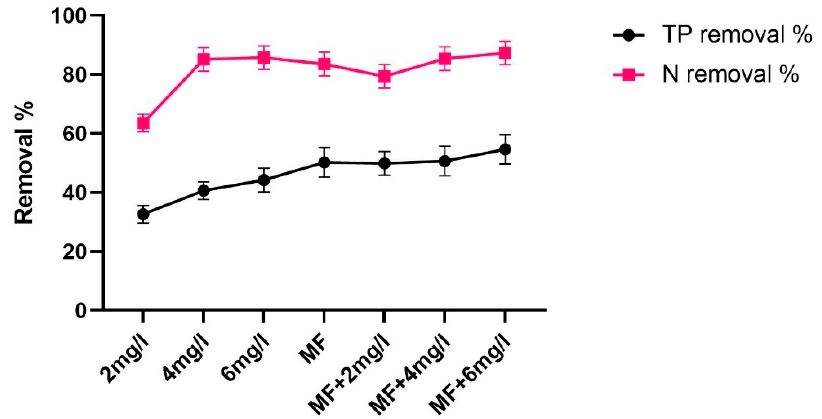
Figure 5. Nutrients removal % of secondary effluents of SHWW treated by different disinfection methods; (l) 2, 4, and 6 mg/L active chlorine; Disinfection with 12% ( w / v ) commercial NaClO (2) MF: disinfection with magnetic field; and (3) MF + 2 mg/L, MF + 4 mg/L, and MF + 6 mg/L; pretreatment with magnetic field then disinfection with NaClO.